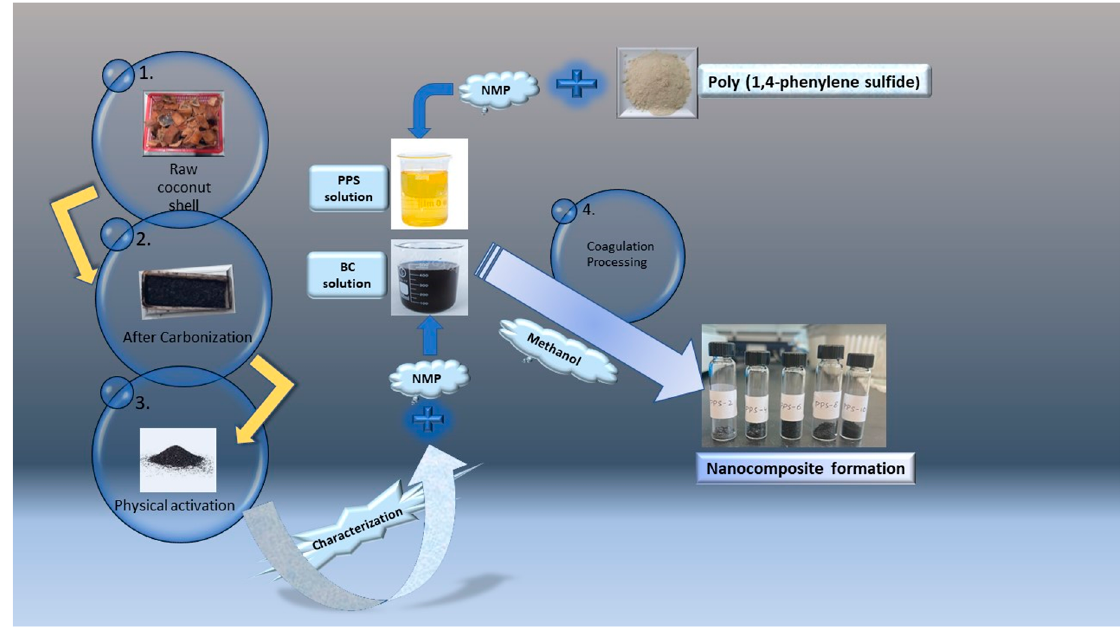
Figure 1. Schematic flow of the experimental workup.